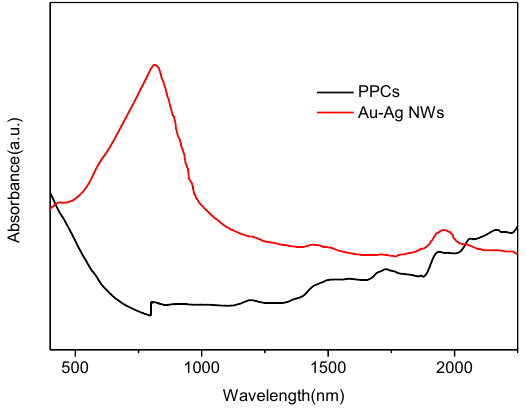
Figure 9. Diffuse reflectance ultraviolet-visible (DRUV-Vis) absorbance spectra of Au-Ag NWs and bare Pichia pastoris cells (PPCs).